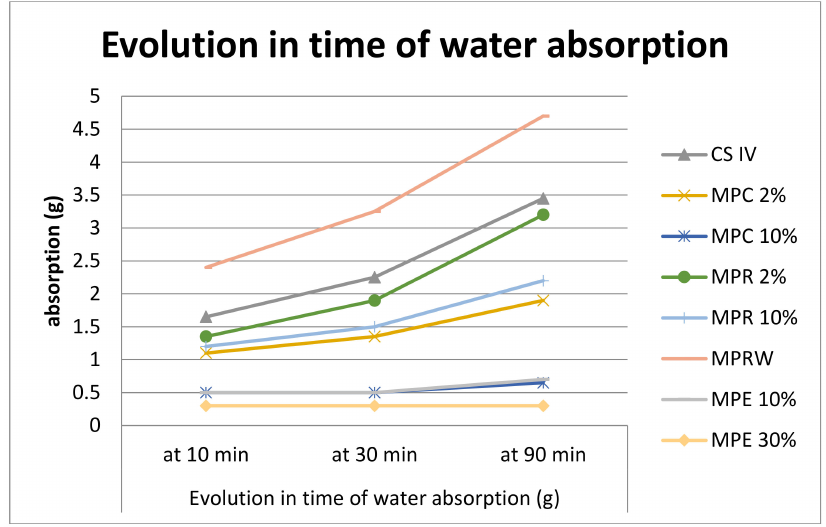
Figure 3. Graphical representation of water absorption at 10, 30, and 90 min for the mortars included in the experimental program.